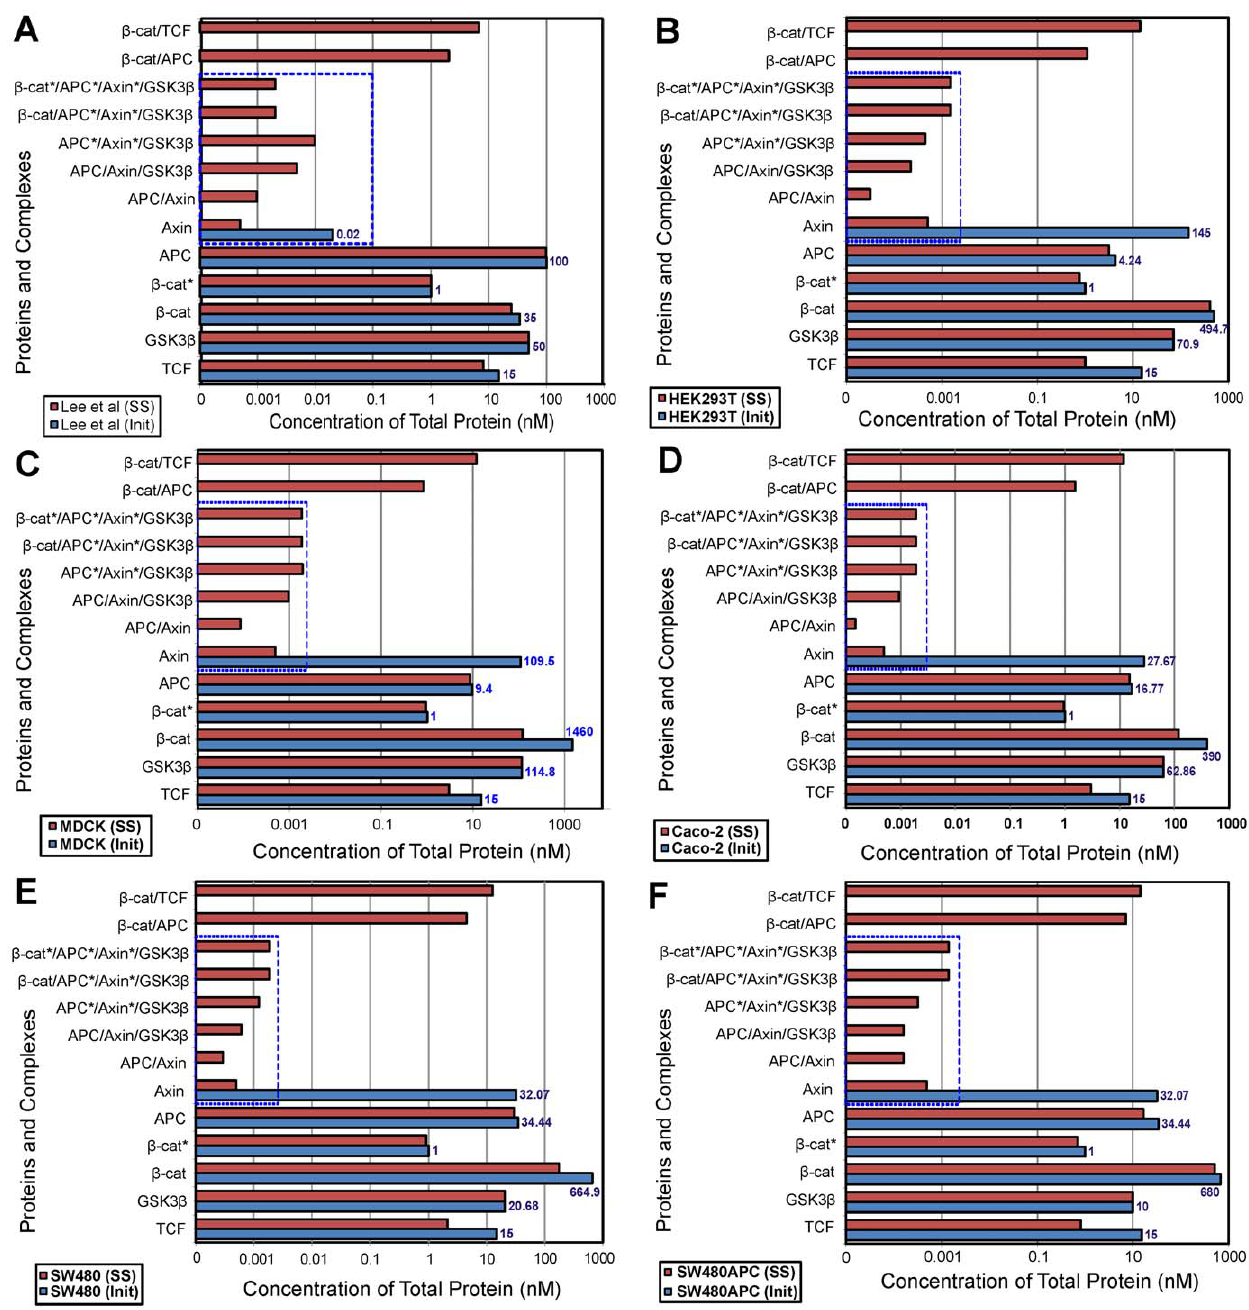
Figure 11. Steady State Analysis of protein complex for different cell lines. Initial to steady state protein redistribution among the interacting complexes of the Wnt signalling pathway for the different cell lines. (A) Xenopus (B) HEK293T (C) MDCK (D) Caco-2 (E) SW480 and (F) SW480APC. Note: Concentrations of protein and complexes involving Axin (in dotted box) are significantly low in all cell lines.